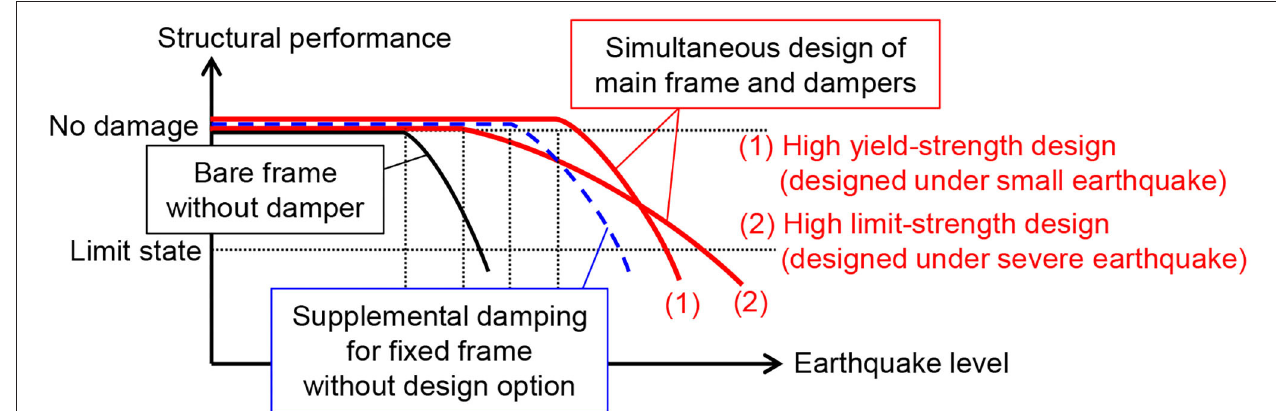
FIGURE 1 | Concept of simultaneous design of main structures and dampers.